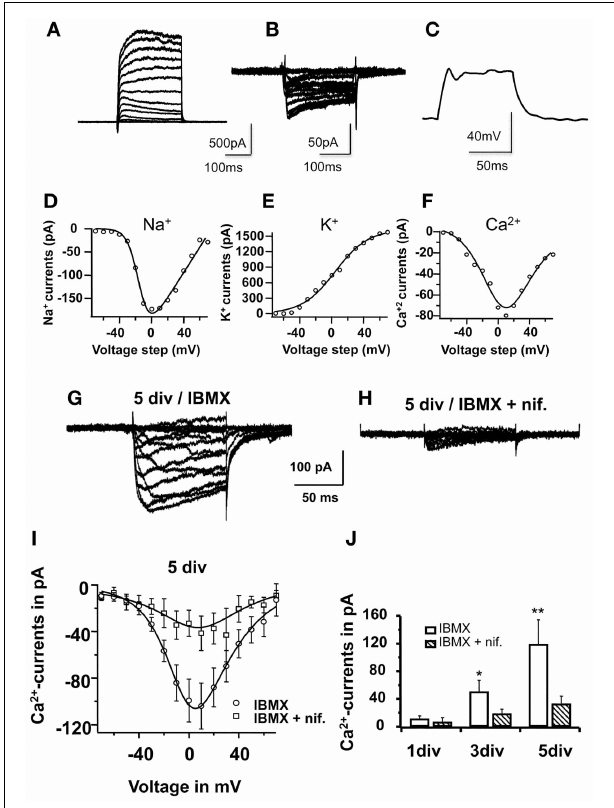
FIGURE 6 | Nifedipine blocked L-type-Ca 2 + -currents in maturing cells. In (A) , voltage-clamp traces showing the I–V relationship (5 sweeps) for Na + and K + -currents in a cell on the 2nd day in vitro . Note the small Na + component in relation to the relatively large K + component, mainly comprised of slow-rectifying K + -channels. In (B) , I–V voltage clamp traces showing Ca 2 + - influx currents in another cell also on the 2nd day in vitro . In (C) , current clamp traces after + 40pA stimulus, recorded form the same cell shown in (A) , showing a small voltage oscillation not sufficient to elicit an action potential. In (E) , (F) , and (G) , Na + , K + , and Ca 2 + - activation curves, respectively; (D,E) were derived from the traces shown in (A) , and (F) was derived from the traces shown in (B) . All cells were recorded on the 2nd day in vitro . The mathematical modeling was based on